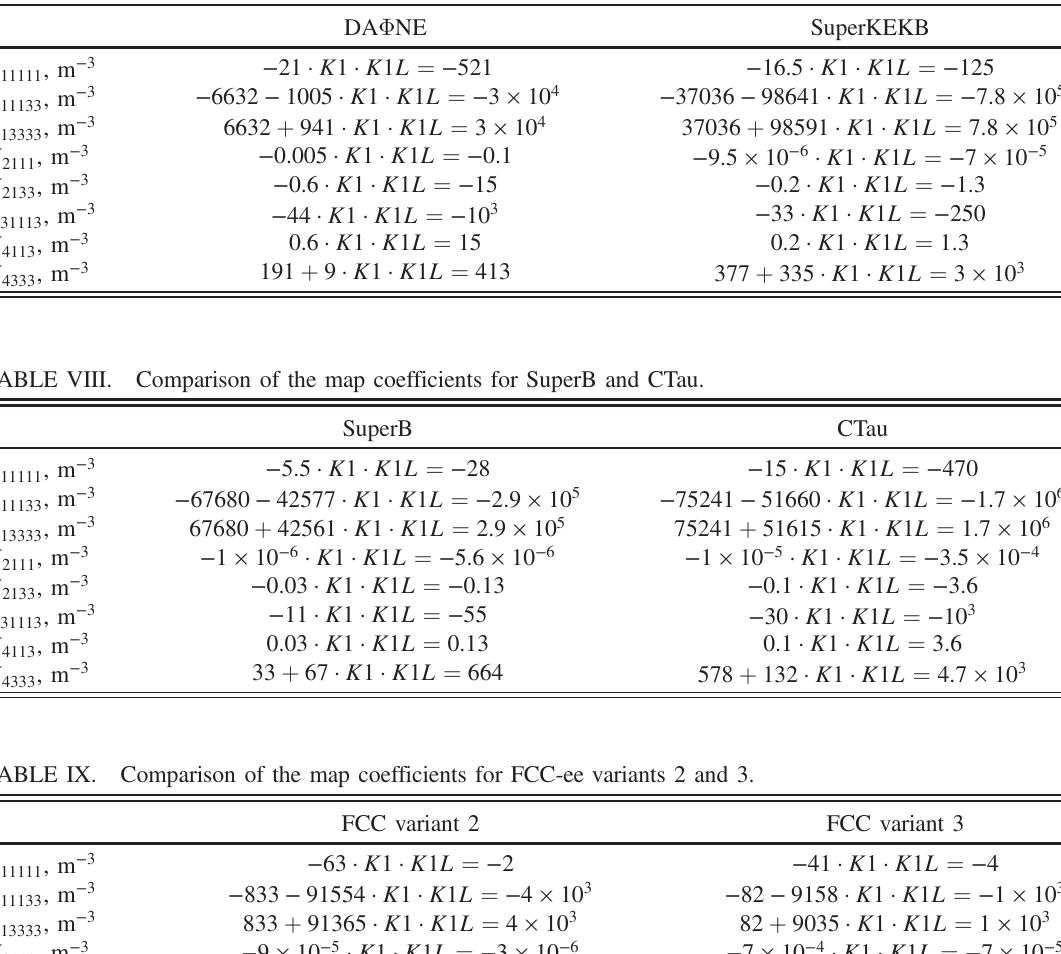
TABLE VII. Comparison of the map coefficients for DA Φ NE and